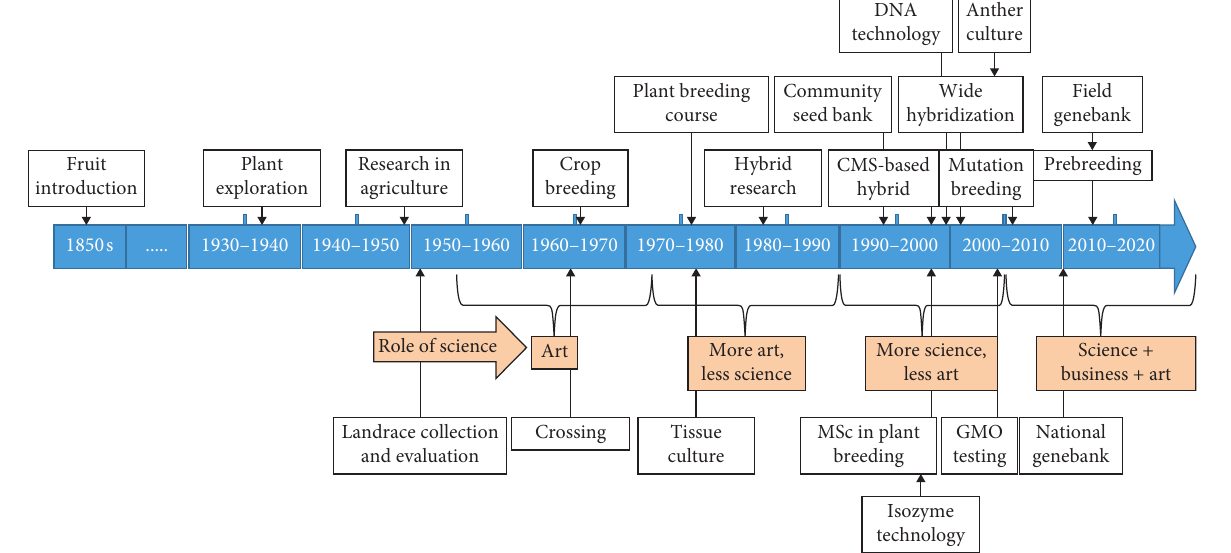
Figure 2: Major plant breeding events in Nepal